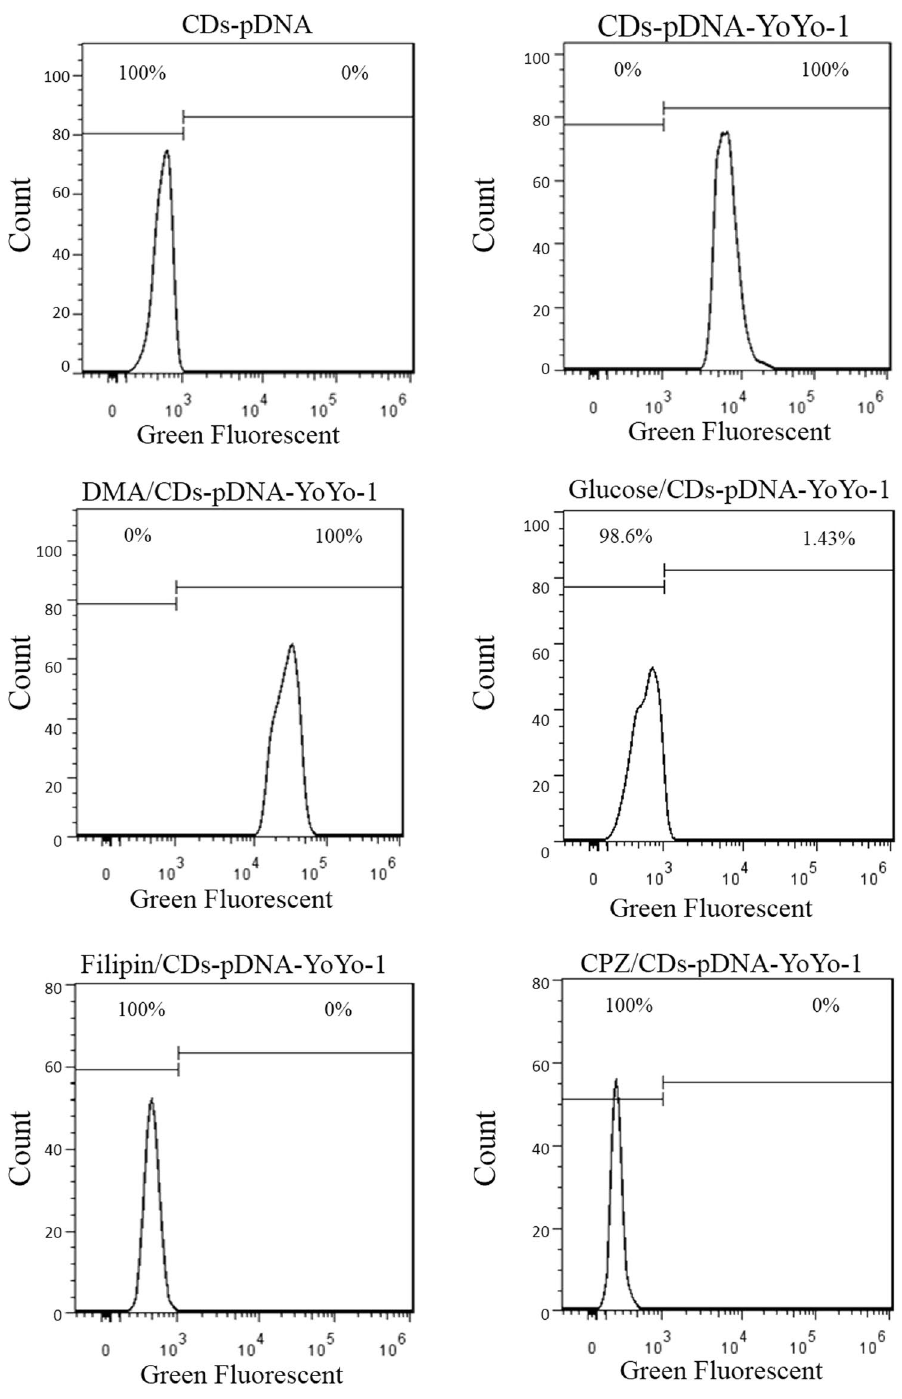
Figure 4. Flow cytometry analyses. MEFs observed using Flow cytometry at excitation wavelengths 488 for green fluorescence, respectively, following inhibition with filipin III, glucose, 5-( N , N -dimethyl)-amiloride (DMA), and chlorpromazine hydrochloride